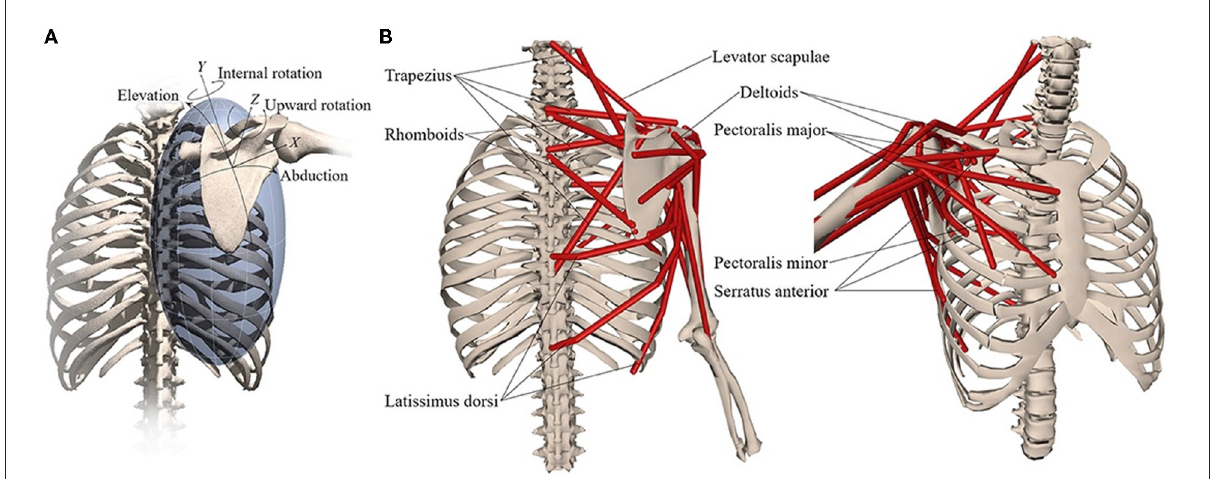
FIGURE3 Musculoskeletal model with (A) scapular degrees-of-freedom and (B) shoulder muscles that control the scapula. Reprinted from Muscle contributions to upper-extremity movement and work from a musculoskeletal model of the human shoulder by Seth et al.